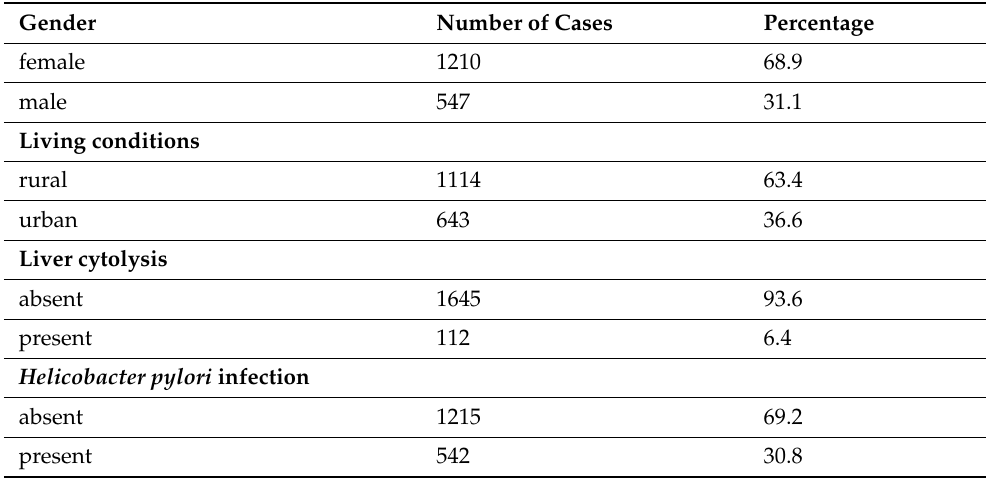
Table 1. Study group with/without H. pylori infection.